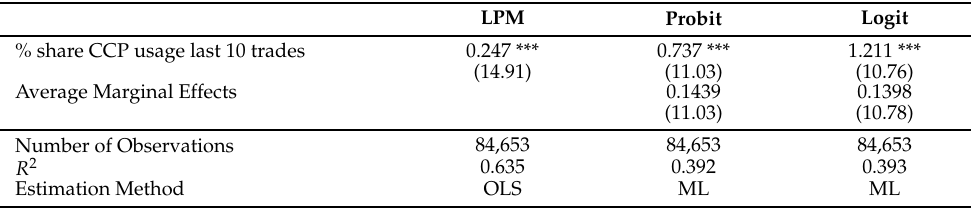
Table 7. Predictive regressions of CCP